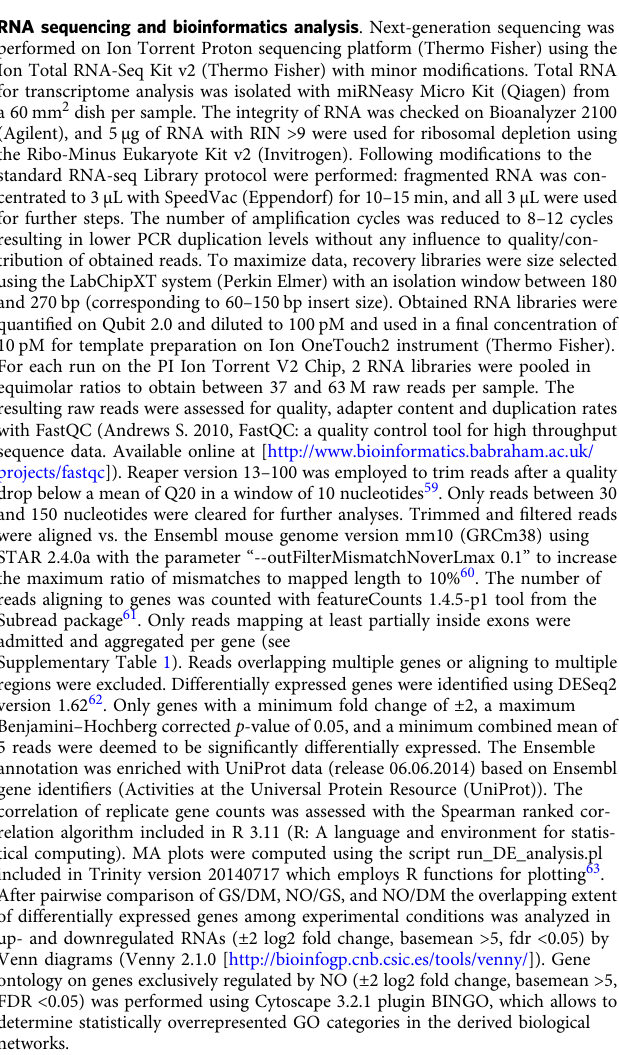
Supplementary Table 4. DNA fragments were recovered and analyzed either by Sequencing or by qRT-PCR (0.5 – 1 μ L of immunoprecipitated chromatin) using the primers listed in Supplementary Table 6. The qRT-PCR analyses were performed in duplicate and the data obtained were normalized to the corresponding DNA input control. Data are represented as relative enrichment (with values for IgG being subtracted from those with antibody). ChIP sequencing and bioinformatics analysis . ChIP samples were processed for sequencing on the Ion Torrent platform using a modi fi ed DNA Library protocol based on the Ion Xpress Plus Fragment Library Kit (Thermo Fisher). 1 – 10 ng dsDNA were used as starting material. After end repair of DNA fragments, Ion Torrent speci fi c and barcoded DNA, Adapters were ligated and covalently bound by nick translation, followed by ampli fi cation with 18 cycles using the components of the Ion Xpress Plus Fragment Library Kit. The fi nal SPRI bead cleanup was performed as double size selection with 0.7× DNA/Bead ratio followed by 0.8× DNA/bead ratio. QC of obtained libraries was done on Bioanalyzer 2100 (Agilent) and quantitation was measured on Qubit 2.0 with HS DNA Assay. Libraries were diluted to a fi nal concentration of 10 pM and used in equimolar ratios for template preparation on Ion Touch 2 instrument. Libraries were pooled on PI Ion Torrent V2 Chips to obtain a minimum amount of 20 M raw reads per sample. The quality of raw reads was assessed using FastQC (see Andrews S. 2010, FastQC: a quality control tool for high throughput sequence data. Available online at [http://www.bioinformatics.babraham.ac.uk/projects/fastqc]). Reads were trimmed for a minimum average quality of Q20 in a window of 20 nucleotides using Reaper 13.274 from the EBI Kraken package 59 . Only reads between 20 and 150 nucleotides were cleared for further analysis. To normalize all samples to the same sequencing depth, 30 million reads per sample were randomly selected for further analysis. These were mapped versus the mm10 (GRCm38) version of the mouse genome with STAR 2.4.2a 60 using only unique alignments to exclude reads with unclear placing (--outFilterMismatchNoverLmax 0.1 --alignIntronMin 2 --alignIntronMax 1 -- alignEndsType EndToEnd --outFilterMultimapNmax 1). The reads were further deduplicated using Picard 1.136 (see Picard: A set of tools (in Java) for working with next-generation sequencing data in the BAM format; [http:// broadinstitute.github.io/picard/]) to avoid PCR artifacts leading to multiple copies of the same original fragment (see Supplementary Table 1). The ENCODE peak caller PeakRanger 1.18 64 was employed in ccat-mode to accommodate for broad peaks. PeakRanger automatically normalizes input and treatment reads and calls peaks taking the background distribution into account. To determine signi fi cant peaks, the data were manually inspected in IGV 2.3.52 to identify reasonable thresholds 65 . Signi fi cant peaks were deemed to show at least 20 treatment reads, a minimum enrichment of treatment versus input reads of 2-fold, and a maximum FDR of 0.05. Peaks overlapping ENCODE blacklisted regions (known mis- assemblies, satellite repeats) were excluded. Only those peaks that were present in at least two replicates (overlap ≥ 1 nucleotide) were permitted for further analysis. To be able to compare peaks in different samples to assess reproducibility, the resulting three lists of signi fi cant peaks (one per treatment replicate) were over- lapped and uni fi ed to represent identical regions. Input and treatment read cov- erage were recomputed for the uni fi ed peaks for each sample and normalized to the same depth using factor normalization. For each peak, input reads were subtracted from treatment reads to correct for mapping irregularities. The background cor- rected counts were then submitted to DESeq 66 for further normalization con- sidering differences of sequencing depth between samples and outlier correction. For the fi nal peak list, values of uni fi ed peaks per sample (treatment reads, input reads, and enrichment) were averaged. Uni fi ed peaks were annotated with Homer 4.7 67 based on data from RefSeq mm10. Peaks were determined to overlap a promoter if their center was located less than 5kb up- or downstream from the TSS of the respective gene. Pro fi les for the peak overlap of e.g. TSS or gene bodies were computed using CEAS 1.0.2 68 using default parameters. The correlation of replicate peak counts was assessed with the Spearman ranked correlation algorithm